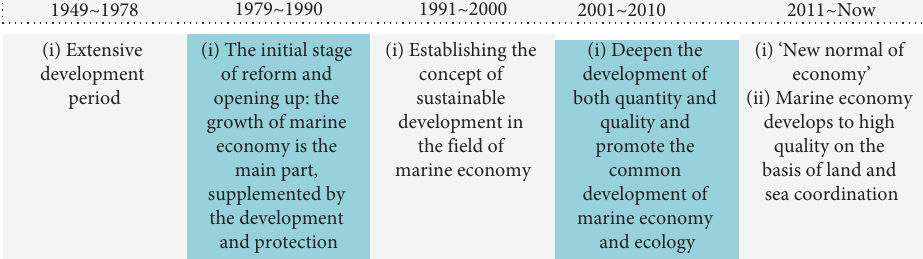
Figure 1: China’s marine policy stage.